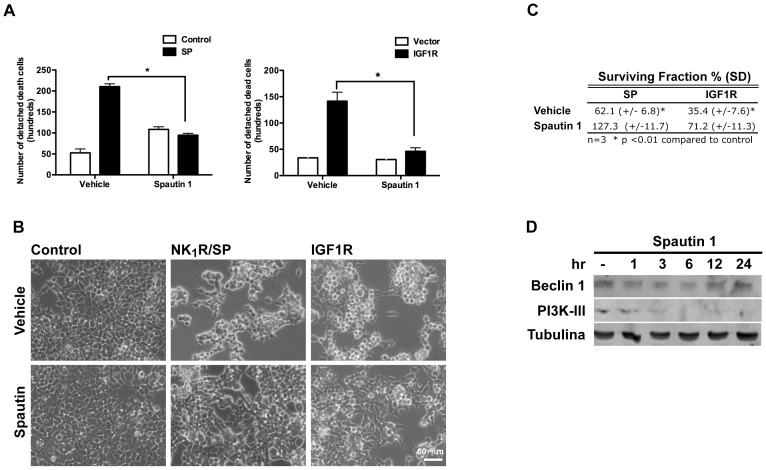
Inhibition of autophagy by Spautin-1 prevents cell death and doubles the clonogenic growth.HEK293 cells were transfected with either the empty vector pcDNA3, NK1R and exposed or not to SP, or IGF1R as indicated. Either Spautin-1 or vehicle DMSO were added as indicated. Detached cells were collected from the media and cell death was determined by trypan blue exclusion 24 hr after cell death induction. Bars represent standard error, (n = 3, * p<0.05). B, bright field image of the cells that remained attached from the same cultures as in A, that were taken for clonogenic growth assays. C, Spautin-1 increases the clonogenic growth of cells expressing NK1R and exposed to SP, or expressing IGF1R compared with vehicle. Equal number of cells from cultures shown in B was seeded, and the number of colonies containing more than 10 cells was scored (details in methods section). The plating efficiency was calculated for control cells and included in the calculation of the survival fraction. D, Spautin- 1 promotes the degradation of both Beclin 1 and PI3K-III. Western blot of total protein extracts taken at the indicated times.